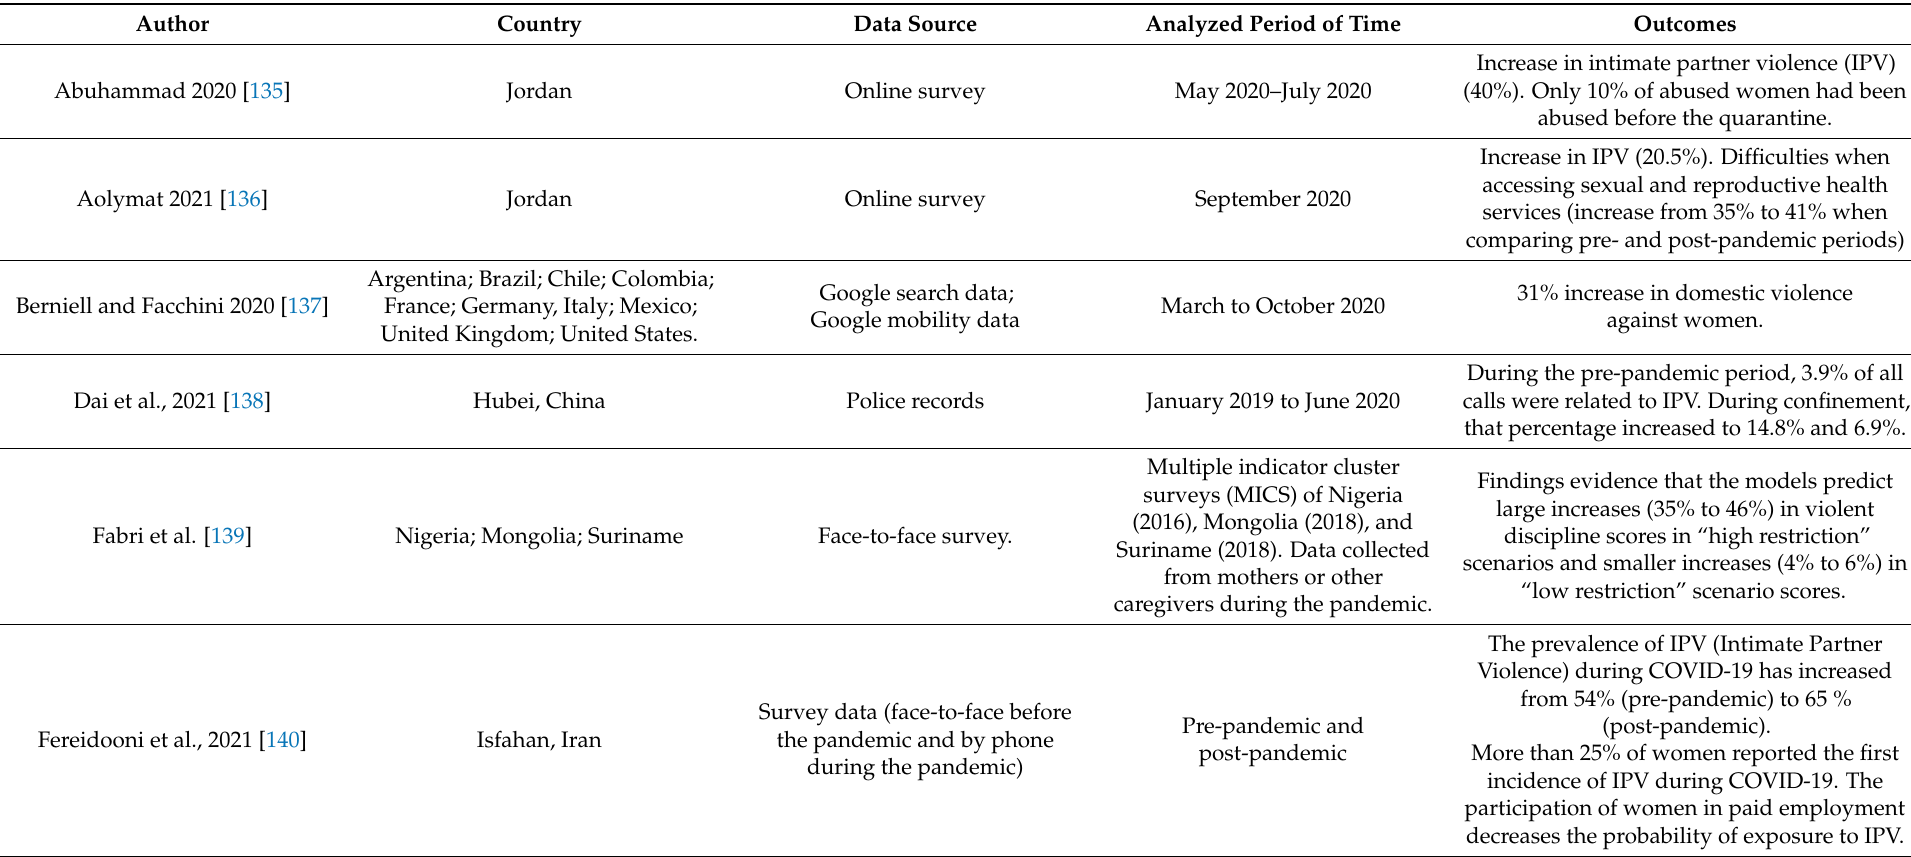
Table 1. Characteristics of violence